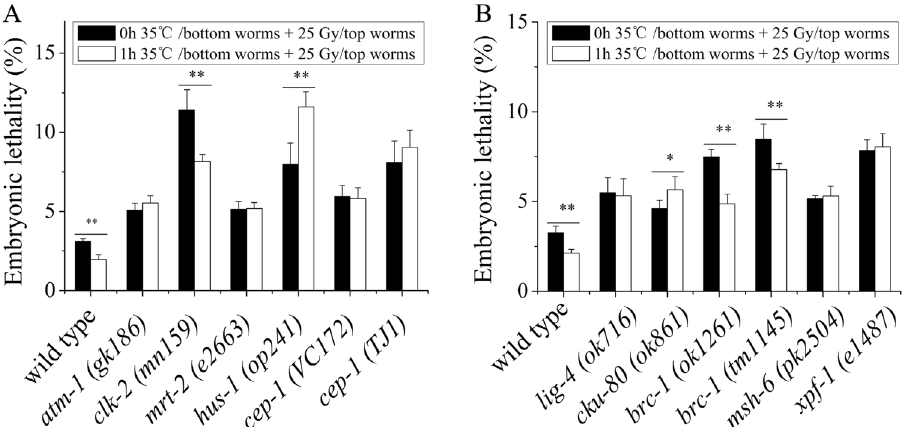
Figure 5. DDR is involved in the regulation of RAR induced by heat-stress volatile signals. ( A ) Embryonic lethality of the top worms whose DNA damage checkpoint function ( atm-1, clk-2, mrt-2, hus-1, and cep-1 ) is absent after coculture with the heat-stressed worms (N2); ( B ) Embryonic lethality of the top worms whose DNA repair function (HR, NHEJ , MMR, and NER) is absent after coculture with the heat-stressed worms (N2). Results are means ± SD (n = 5, * P < 0.05, ** P <